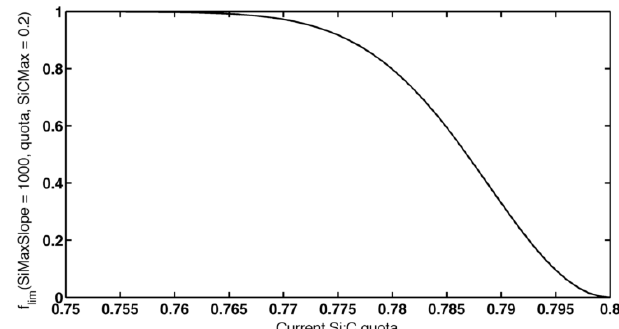
Figure A4. Change in limiter function with Si:C quota. with N:C quota. lim